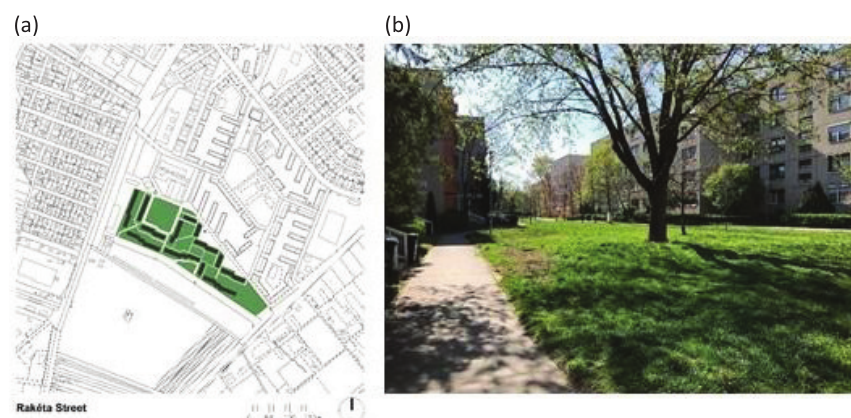
Figure 7. Rakéta Street HE: (a) Layout and (b) car‐free street with inner green space between the low‐rise slabs. Csillagtelep. It was thought that newcomers could use the existing public infrastructure of the